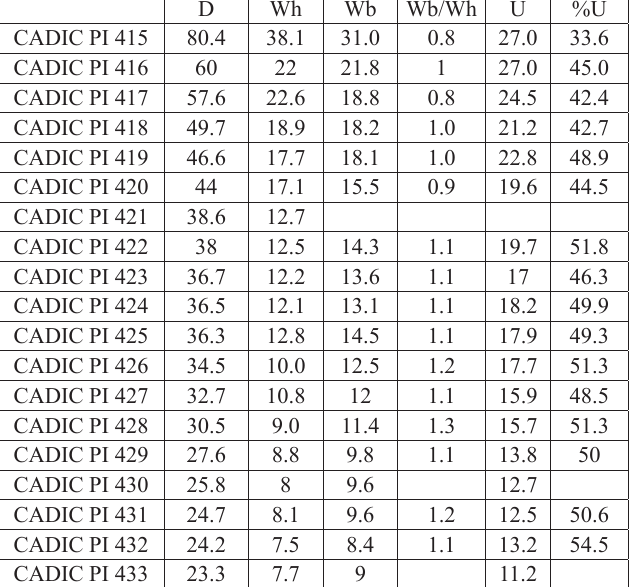
Table 2. Dimensions (in mm) of Gaudryceras submurdochi sp. nov. Abbreviations: D, diameter; U, umbilical diameter; %U, umbilical dia- meter as % of D; Wb, whorl breadth at a given D; Wh, whorl height at a given